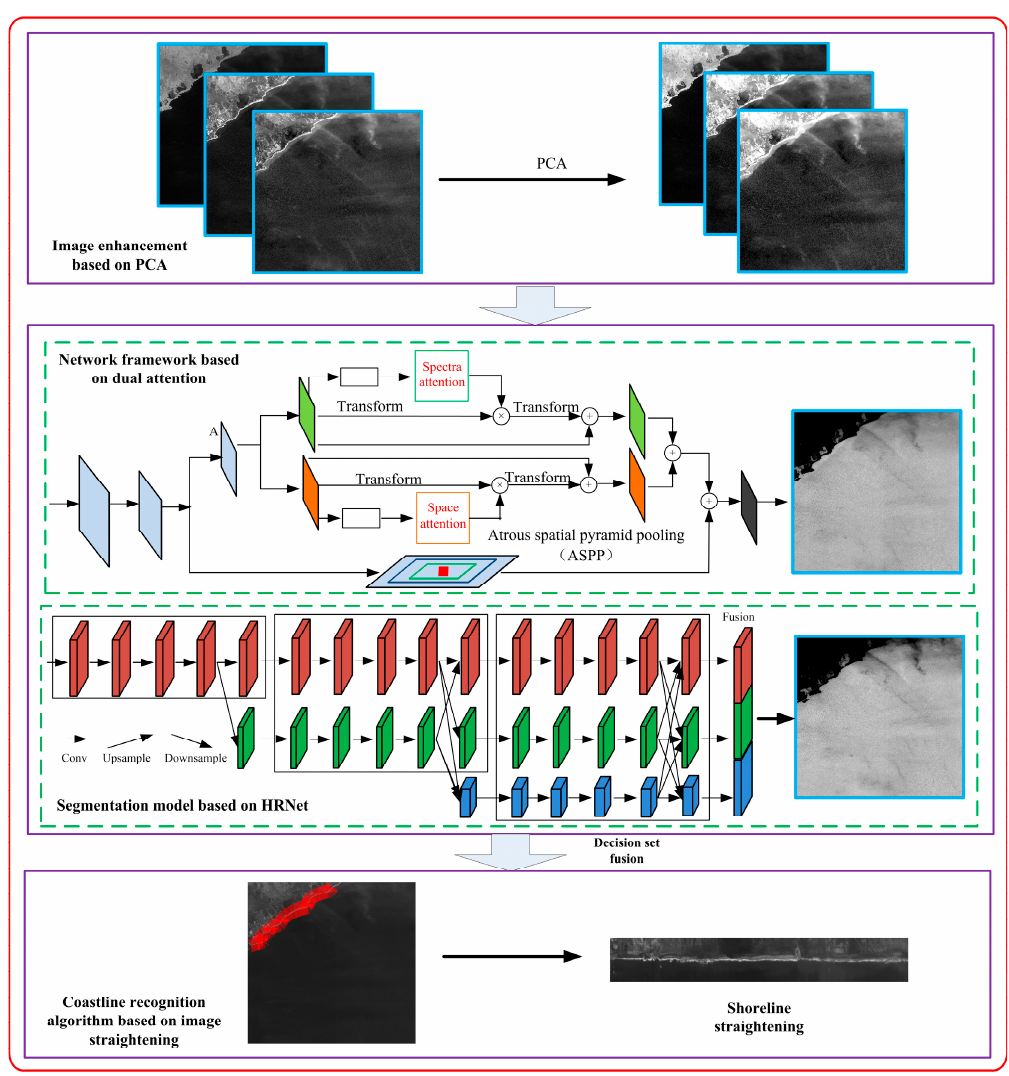
Figure 1. Flow chart of the algorithm.